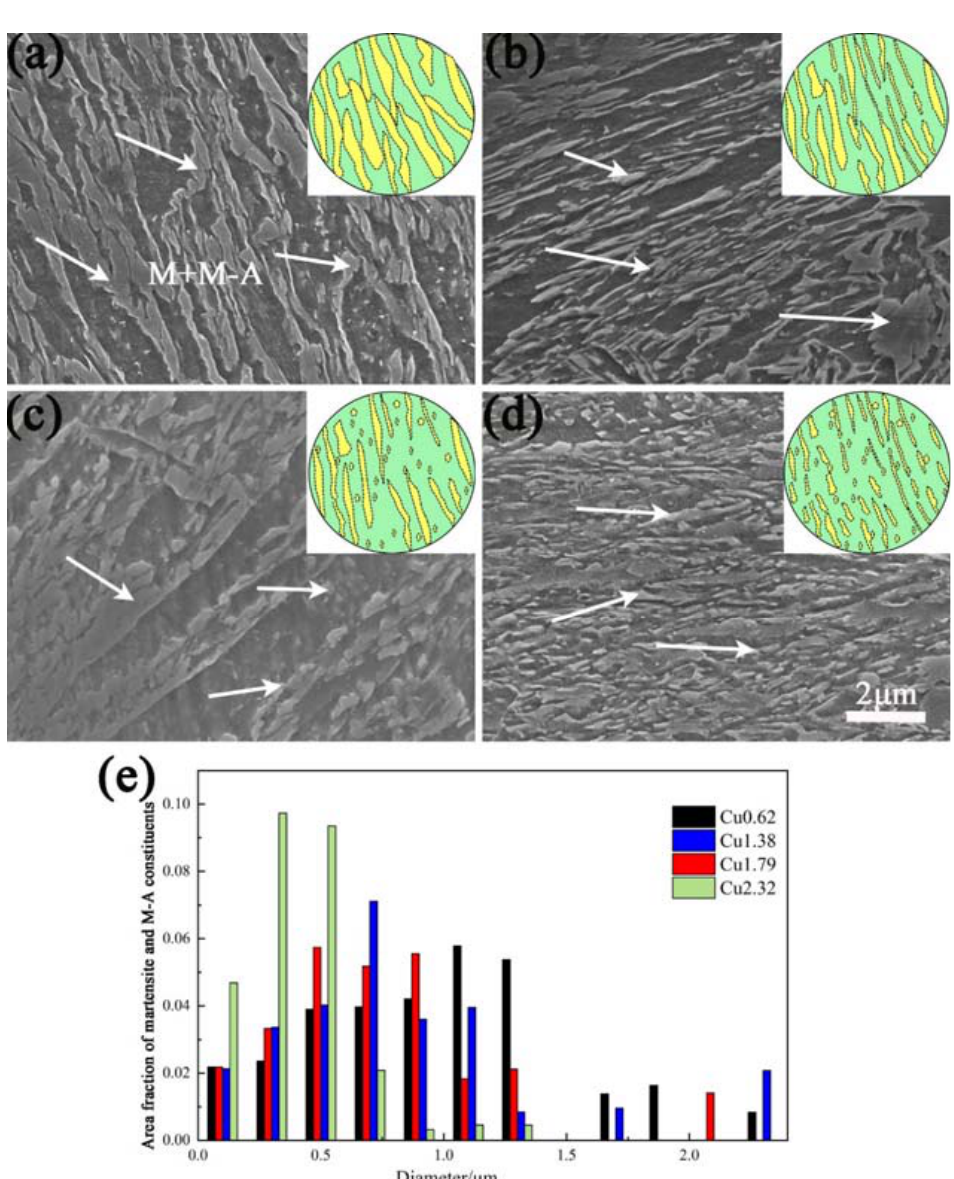
Figure 11. High-magnification SEM morphologies with schematic diagram ( a – d ) and equivalent Figure 11. High ‐ magnification SEM morphologies with schematic diagram ( a – d ) and equivalent di ‐ diameter distribution of martensite and M-A constituents ( e ). ( a ) Cu 0.62, ( b ) Cu 1.38, ( c ) Cu 1.79, ( d ) Cu 2.32. The area fraction and size of martensite and M-A constituents of deposited metals decreases with increase of Cu